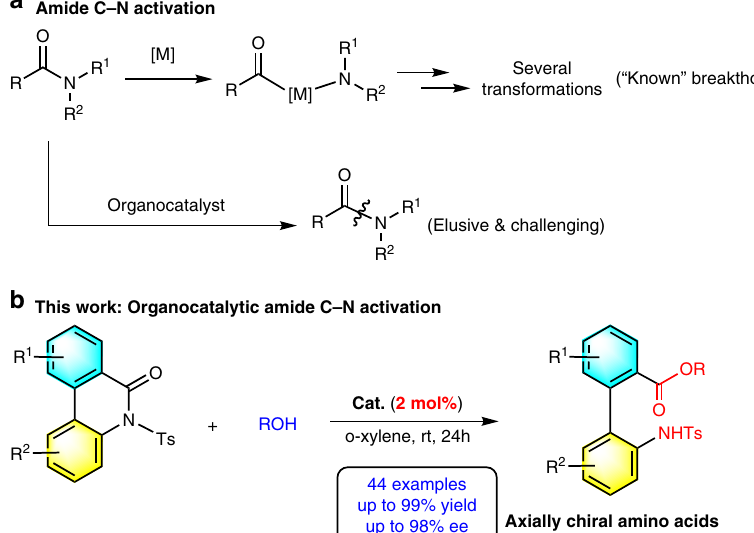
Fig. 1 Approaches for amide C – N bond activation. a Metal-catalyzed amide C – N activation. b Organocatalytic asymmetric N -sulfonyl amide bond